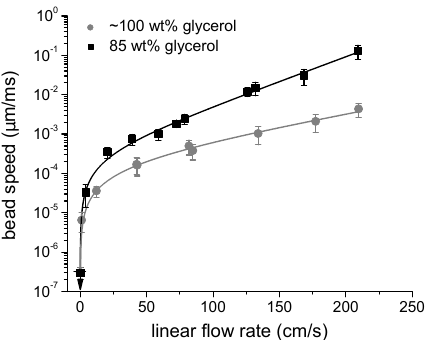
Fig. 5. Bead speed in glycerol particles vs. gas flow rate for ∼ 100wt% glycerol and 85wt% glycerol where the symbols rep- resent the average bead speed and the error bars represent 1 σ